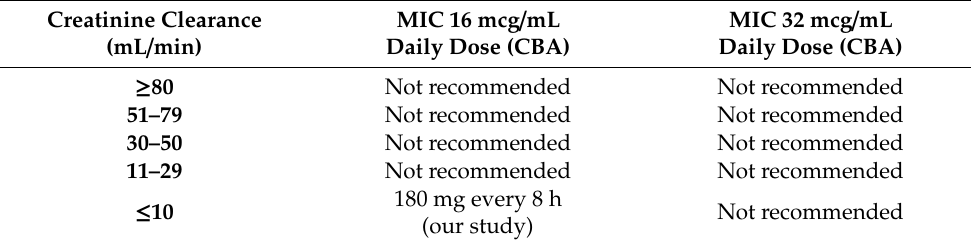
Table 6. The recommended dose based on the ability to achieve PTA target at various MICs. Creatinine